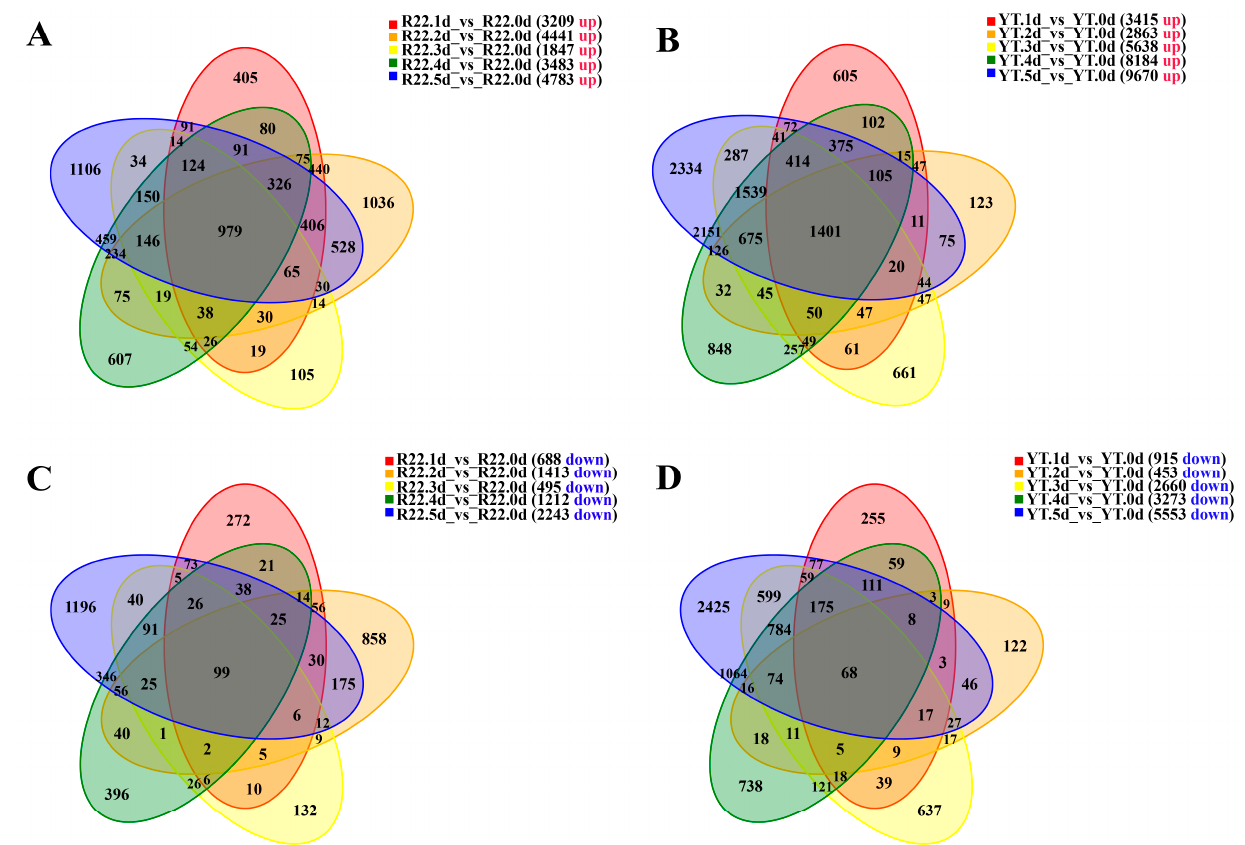
Figure 1. Venn plots of DEGs in ROC22 and YT93-159 post- S. scitamineum infection: Up-regulated DEGs in ROC22 ( A ) and YT93-159 ( B ), and down-regulated DEGs in ROC22 ( C ) and YT93-159 ( D ), respectively.